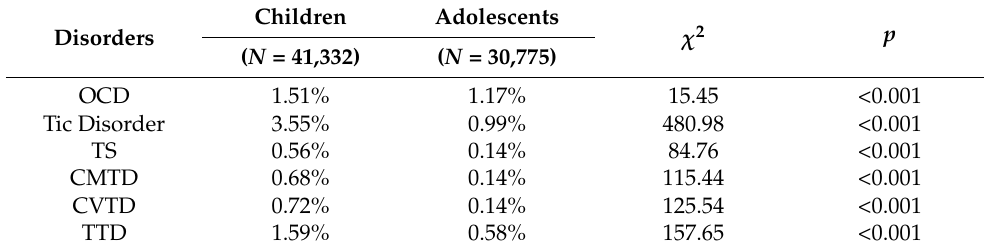
Table 3. Age difference in OCD, TD and TD